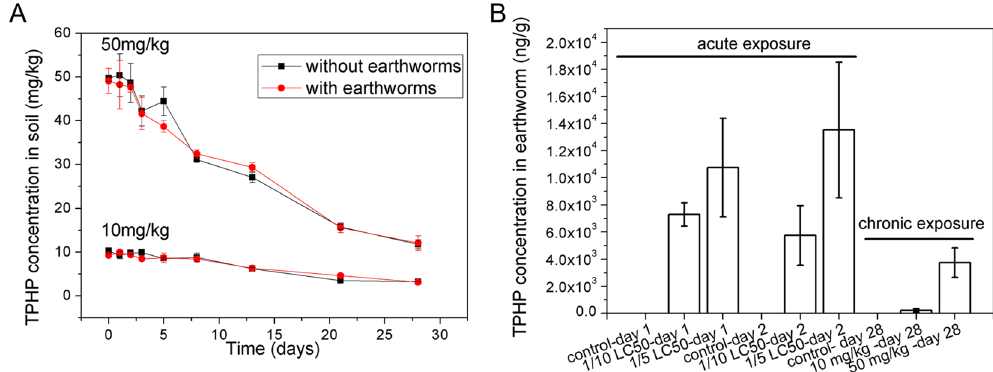
Figure 1. Concentrations of TPHP ( A ) in soil with and without earthworms through 28 days and ( B ) in earthworms after acute and chronic exposure on a dry weight basis. Note that acute and chronic exposures